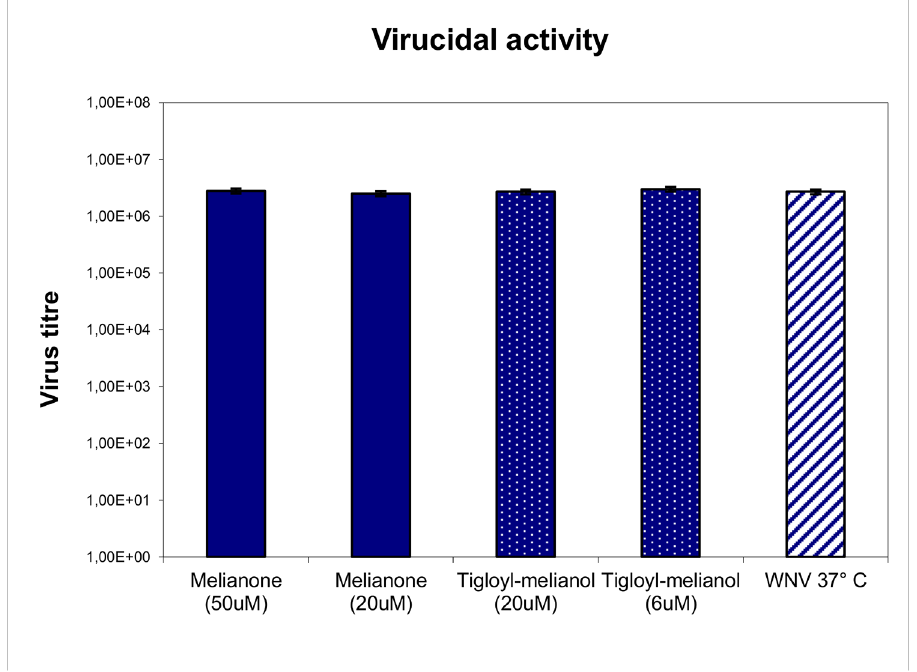
Fig 1. Virucidal activity of melianone and 3- α -tigloyl-melianol. Treatment at 37°C for 45 min. with melianone and 3-tigloyl-melianol at different concentrations doesn ’ t affect the WNV infectivity. Each value represents a mean of duplicate